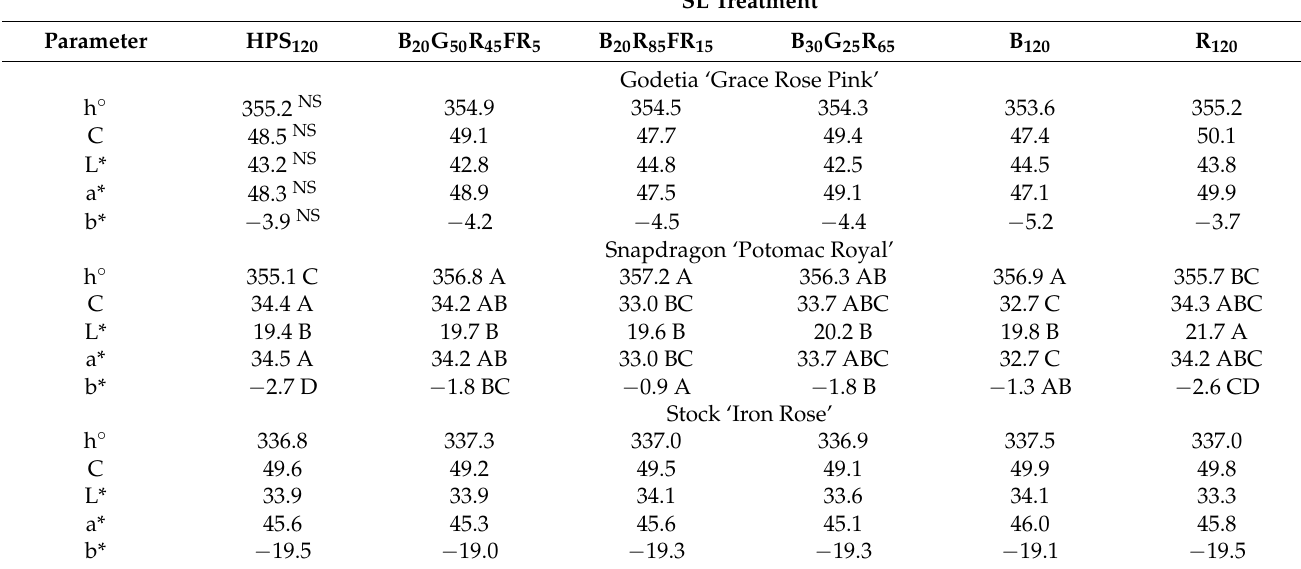
Table 4. Adjusted hue angle (h ◦ ), chroma (C), and Hunter CIELAB (L*, a*, b*) values at harvest for godetia, snapdragon, and stock grown under six different supplemental lighting (SL) treatments. SL treatments consisted of either 460 W high-pressure sodium fixtures (HPS 120 ; LR48877; P.L. Light Systems, Beamsville, ON, Canada), 631 W light-emitting diode (LED) fixtures (B 20 G 50 R 45 FR 5 ; VYPR 2p; Fluence, Austin, TX, USA), 325 W LED fixtures (B 20 R 85 FR 15 ; LumiGrow Pro 325; LumiGrow, Emeryville, CA, USA), 600 W LED fixtures (B 30 G 25 R 65 ; LX601G, Heliospectra, Göteborg, Sweden), a combination of 72 W LED fixtures (B 120 ; HortiLED MULTI, P.L. Light Systems) and 625 W LED fixtures (R 120 ; LumiGrow Pro 650E, LumiGrow), or 625 W LED fixtures (LumiGrow Pro 650E; LumiGrow). Letters indicate mean separations across treatments using Tukey–Kramer honestly significant difference ( HSD ) test at p ≤ 0.05. SL